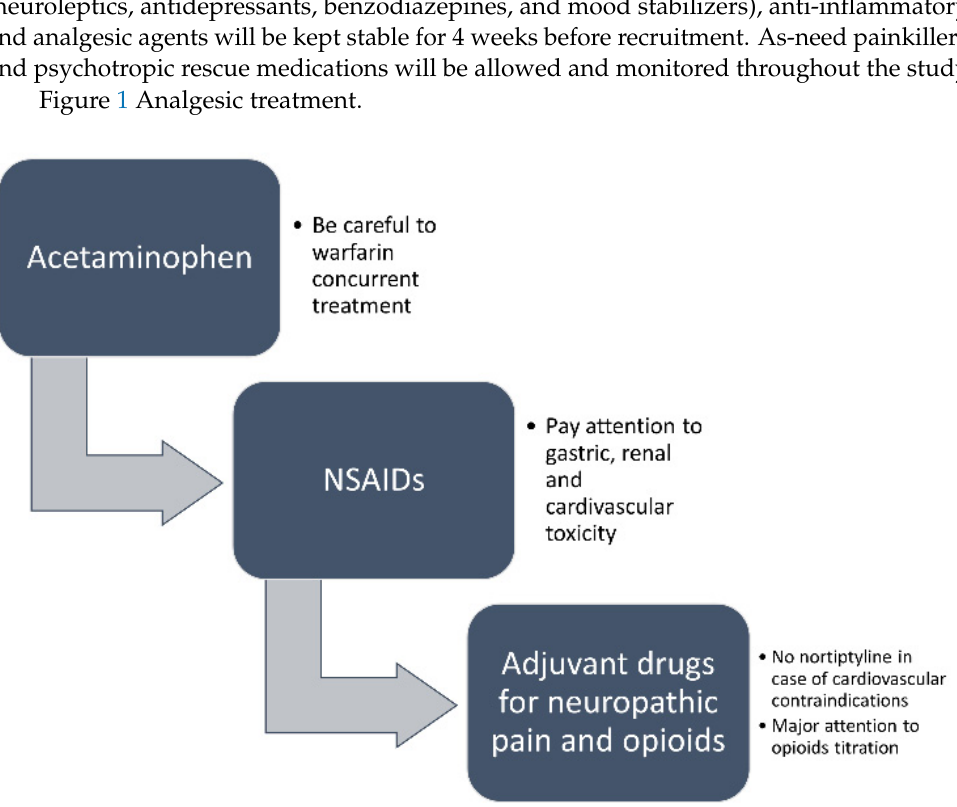
Figure 1. Schedule of analgesic treatment after observational pain assessment.